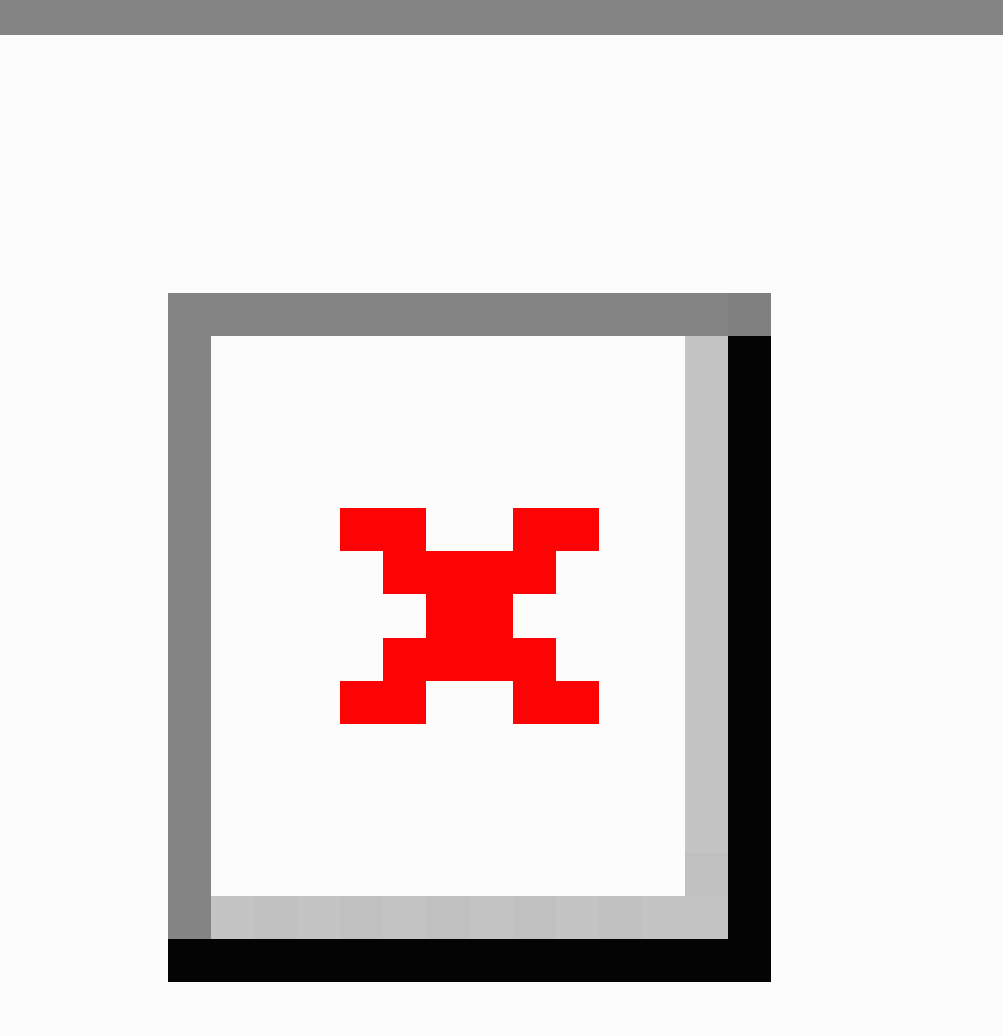
Figure 2. First page of GSS. History of medical events are marked on the calendar with numbers explained in a box (arrow). Changes in MD values indicate possibility of deterioration of glaucoma stage. Prescription details are shown by gray or colored bar, respectively. IOP: intraocular pressure, MD: mean deviation, R: right eye, L: left